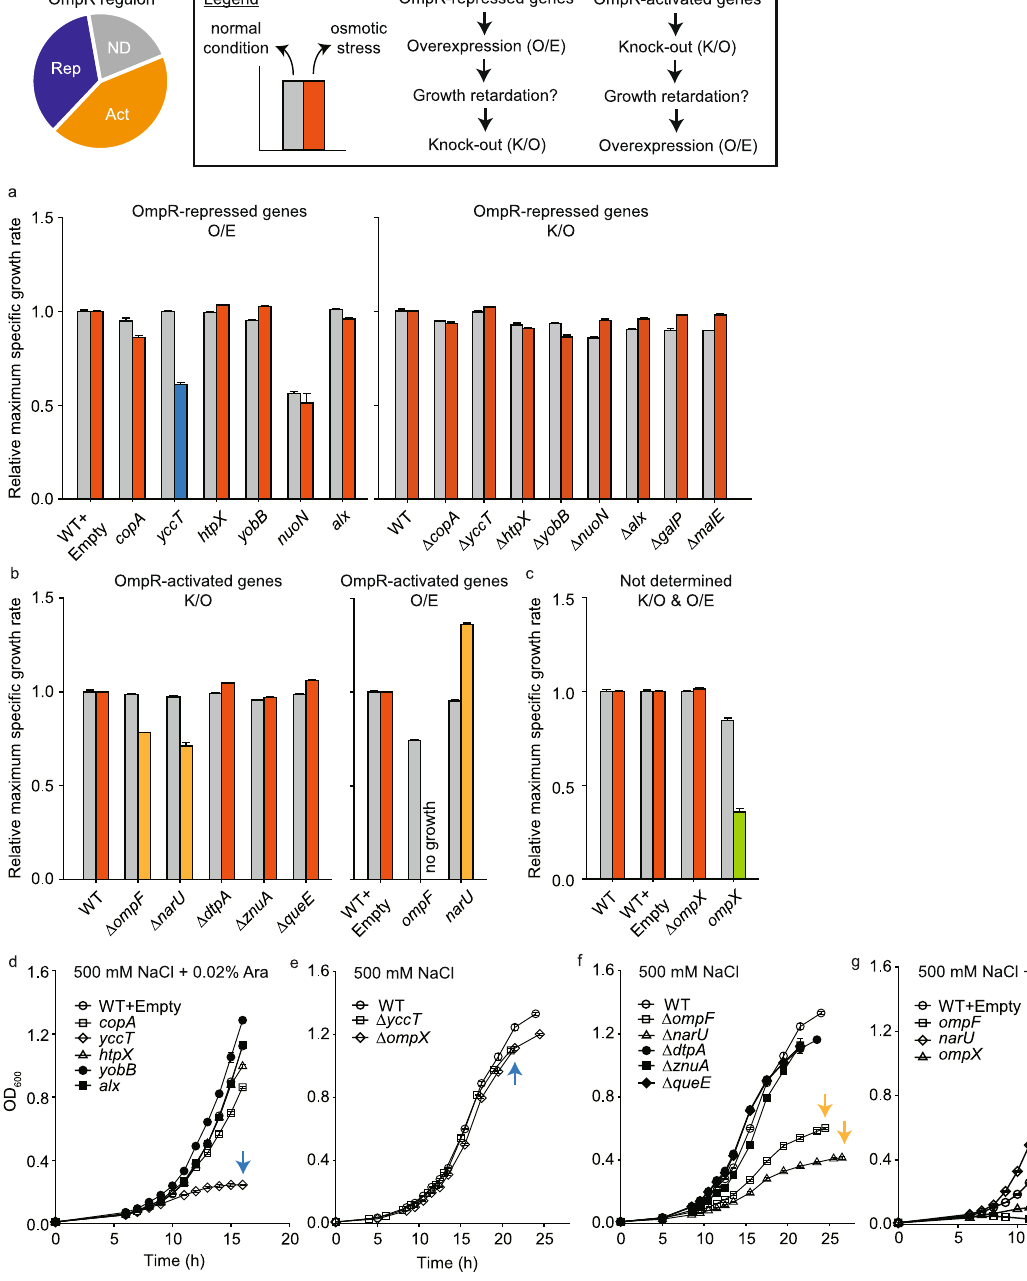
Figure 4. Examination of physiological role of OmpR regulon under osmotic stress. ( a ) OmpR-repressed genes were overexpressed (O/E) to investigate their effects on cellular growth rate under normal and osmotic stress conditions. If mutant strains showed retarded growth rate under osmotic stress conditions, the corresponding genes were knocked-out (K/O) and growth rates of mutant strains were measured. In order to eliminate any potential caveat from differential expression of membrane-bound proteins, we additionally constructed mutant strains of OmpR-repressed genes. The same approach was applied to ( b ) OmpR-activated genes and ( c ) Not- determined genes. The relative maximum specific growth rates were represented as normalized by those of wild-type strains under each condition. Time-course growth curves (OD at 600 nm) of mutants were depicted depending on ( d , g ) overexpression and ( e , f ) knock-out conditions. For the osmotic stress condition, the growth media were supplemented with 500 mM NaCl. The mean and standard deviation from independent biological triplicate were